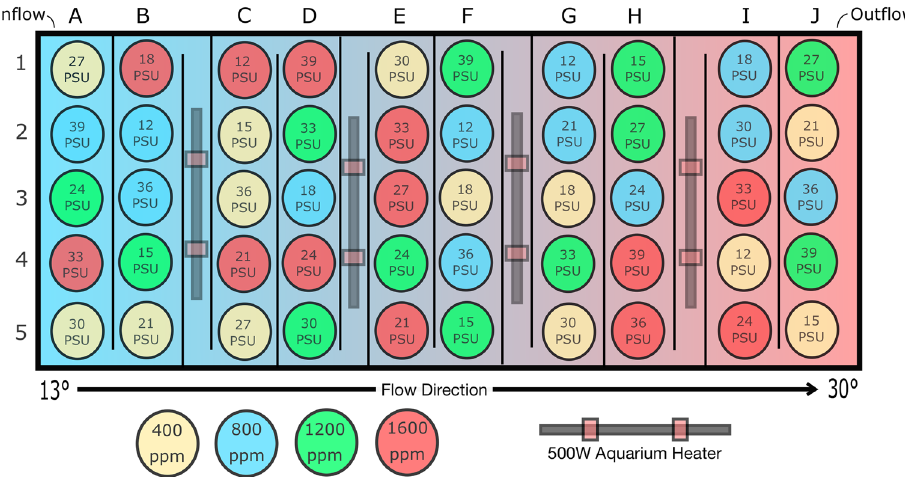
Figure 1. Growth experiment tank layout. The environmental gradient culturing tank houses 50 32 oz PET cups (circles) in which larvae were cultured. Each cup contains water of unique combinations of temperature, salinity, and acidification. Water enters the tank from the left side, then flows directionally across a series of weirs (black vertical lines) toward the outflow on the right. Along the way, water passes through four